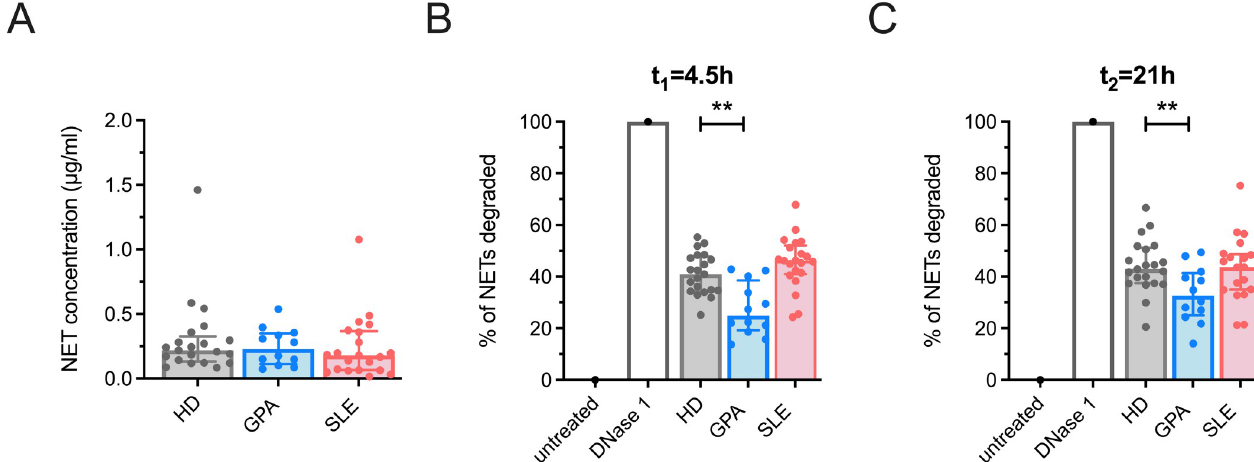
Fig 4. Quantification of NETs isolated from peripheral blood and DNase 1 assay. (A) NET-concentrations were determined by a NET-ELISA in EDTA- plasma (HD, n = 21; GPA, n = 12; SLE, n = 21). NET degradation activity of DNase 1 in serum was determined after t 1 = 4,5 h (B) and t 2 = 21 h (C) in HD, n = 21; GPA, n = 12; SLE: n = 21. Median values ± IQR are presented. Data were analysed by Kruskal-Wallis-test ( α = 0.05), � p < 0.05, �� p < 0.01.